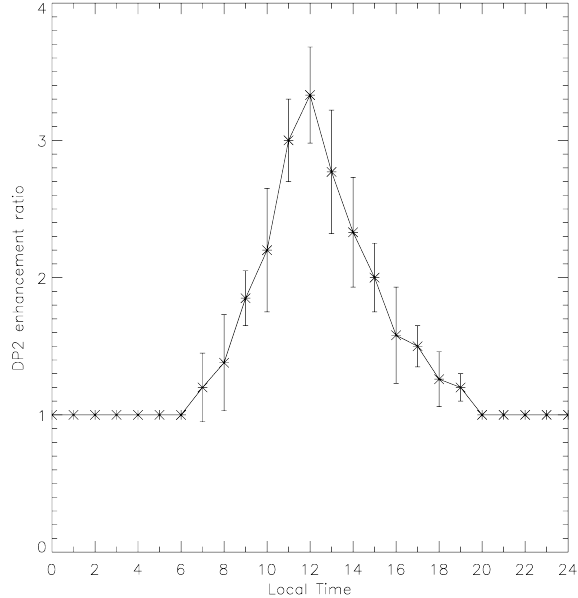
Fig. 3. Latitudinal profiles of DP2 disturbance on 11 March at 09:45UT and 12:15UT. Fig. 4. Diurnal variation of DP2 enhancement ratio average in 1993 at dip-equator (NIE) compared to low latitude (TAM).